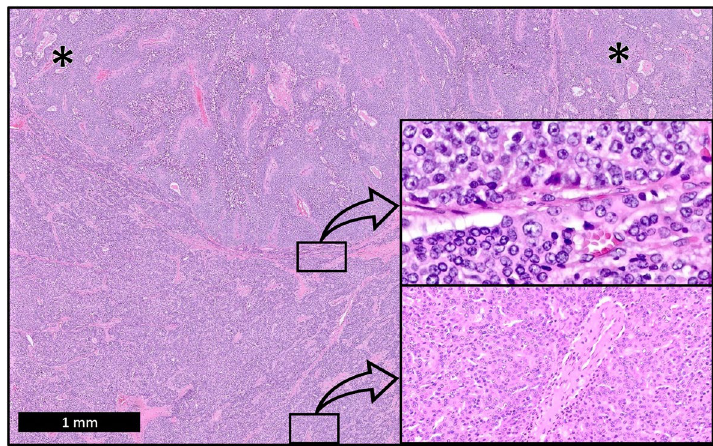
Fig. 3 Two distinct histological patterns of the tumor are identified, with cholangiocytic differentiation (asterisks) identified in the top lesion (H&E, low power). Small uniform tumor “cancer stem cells” with small basophilic vesicular nuclei, occasional inconspicuous nucleoli, scant pale eosinophilic cytoplasm, indistinct cell borders, and frequent mitoses are seen throughout and are prominent at transitional zones (top inlay; H&E, high power). Tumor cells of similar cytology with more abundant eosinophilic cytoplasm surround an unpaired artery in the HCC-like areas (bottom inlay; H&E, intermediate power)